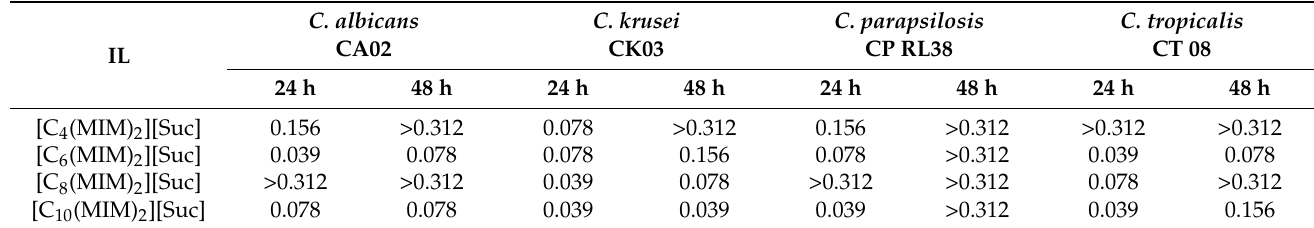
Table 2. MICs (in mM) of DILs against Candidas , after 24 and 48